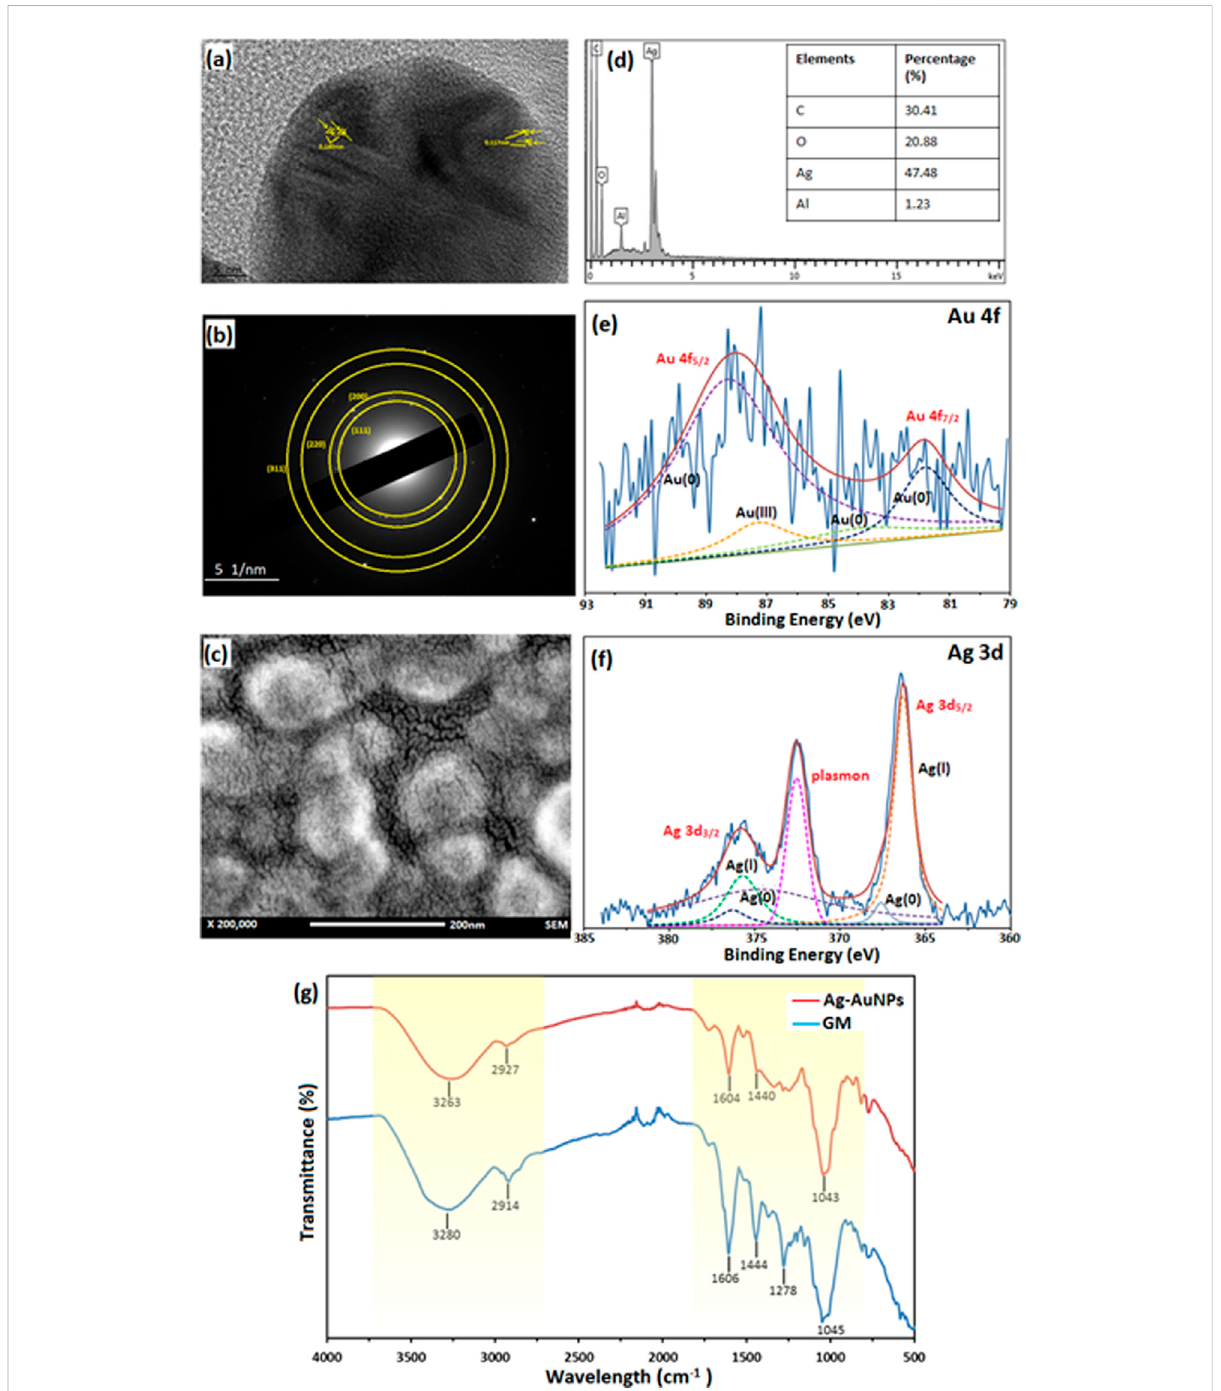
FIGURE 2 CharacterisationofsampleAu:Ag 1:9. (A) Lattice spacing ofTEMimage, (B) SAEDofAu-AgNPs, (C) FESEM imageof Au-AgNPs, (D) EDXspectra, (E) XPS spectra of Au-AgNPs (Au 4f band), (F) XPS spectra of Au-AgNPs (Ag 3d band), and (G) FTIR spectrum of Au-AgNPs and GM